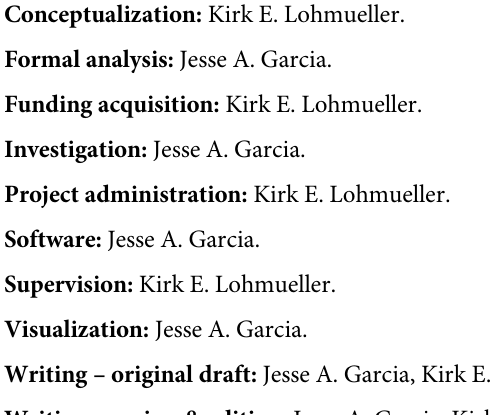
S2 Table. Summary of empirical data used in the figures. The number of pairs of variants in each analysis is in the “Number of pairs” column. Whether or not matching was required between synonymous and nonsynonymous pairs of variants is indicated in “Matching between S and NS pairs” column. The allele count of variants included in the analysis are indicated in the “Allele count of variants” column. The data set from which variants come from and any notes included are indicated in the “Notes” column. If “Matching between S and NS pairs” is “Yes”, then the total number of NS and S pairs are reported in the “Number of pairs”